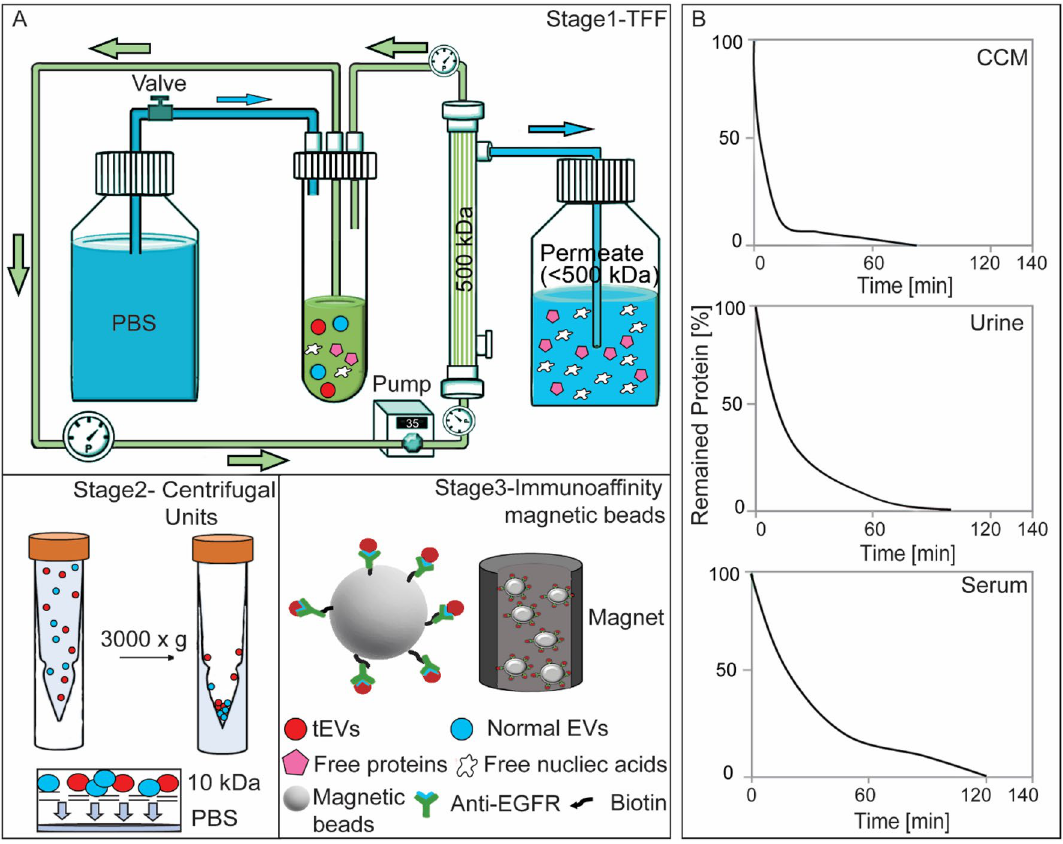
Figure 1. The Immunomagnetic sequential ultrafiltration (iSUF) platform. ( A ) Schematic representation of iSUF stages 1, 2, 3, including tangential flow filtration (TFF) purification, centrifugal unit enrichment, and tEV immunoaffinity isolation, respectively. In stage 1, biofluids were processed using a 500 kDa TFF filter, EVs were retained in the retentate and enriched in 7 mL while free proteins and nucleic acids permeated through the TFF filter. Then the PBS valve was opened to start TFF diafiltration until removing up to 99% of free proteins. Finally, EVs were recovered in 2 mL of PBS after flushing the TFF system with air. In stage 2, EVs were centrifuged using a 10 kDa centrifugal unit at 3000× g and enriched in 100 μL. In stage 3, tEVs were captured using antibodies immobilized to streptavidin-coated magnetic beads (i.e., EGFR) and subsequently pulled out with a magnet. ( B ) iSUF stage 1 purification performance for different biofluids. Cell supernatant (CCM), urine, and serum took 80, 100, and 120 min to obtain up to 99% efficiency of free protein and nucleic acid tion depends on the hollow fiber membrane pore size (MWCO), which should be large enough to permeate proteins and free nucleic acids while small enough to retain EVs. During the enrichment step, freely permeable molecules are partially removed. To remove the remaining contaminants, a diafiltration step with PBS is neces- sary. The diafiltration processing time is proportional to the biofluid volume in the system 35 , so diafiltration started with a total biofluid volume of 7 mL, which was the sum of the dead volume of the self-build TFF system (2 mL in the product container) and 5 mL remaining in the different tubing of the setup. Liquid in the tubing was necessary to protect the EVs from drying out and to enable constant volume diafiltration. Hence, CCM and urine were pre-enriched to a total volume of 7 mL. For the processing of serum, 0.5 mL of sample was diluted to a total volume of 7 mL in PBS and then processed with diafiltration. The input flow rate was kept at 35 mL/min using a peristaltic pump (Cole-Parmer, Vernon Hills, IL). The sample volume after stage 1 was approximately 2 mL (dead volume of the TFF system). At stage 2, ultra-centrifugal units with 10 kDa MWCO were used to further enrich the samples to 100 μL at 3000× g for 20 min. For specific isolation of subpopulations of EVs, stage 3 of iSUF, streptavidin-coated magnetic beads were functionalized with biotinylated antibodies (e.g., EGFR, EpCAM, HER2) overnight at 4 °C to target tEVs. 100 μL of the processed sample (after stage 2) was incubated with the antibody-coated beads for 1 h at RT. The efficiency of the iSUF platform for isolating tEVs was evaluated using flow cytometry and total internal reflection fluorescent (TIRF) microscopy. EVs were also characterized for their size, concentration, morphology, and molecular content (e.g., protein, RNA). Processing biofluids using ultracentrifugation (UC).